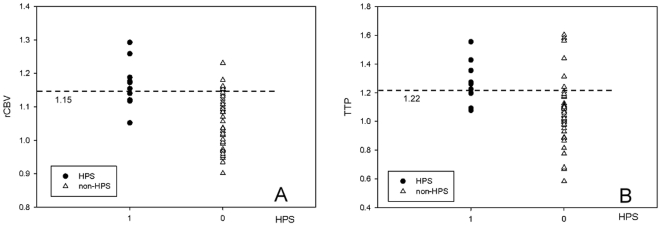
rCBV (A) and TTP (B) in HPS and non-HPS patients.From univariate discrimination analysis by receiver operating characteristic (ROC) curves, the threshold levels for the best discrimination of HPS and non-HPS are 1.15 and 1.22 for rCBV and TTP, respectively.